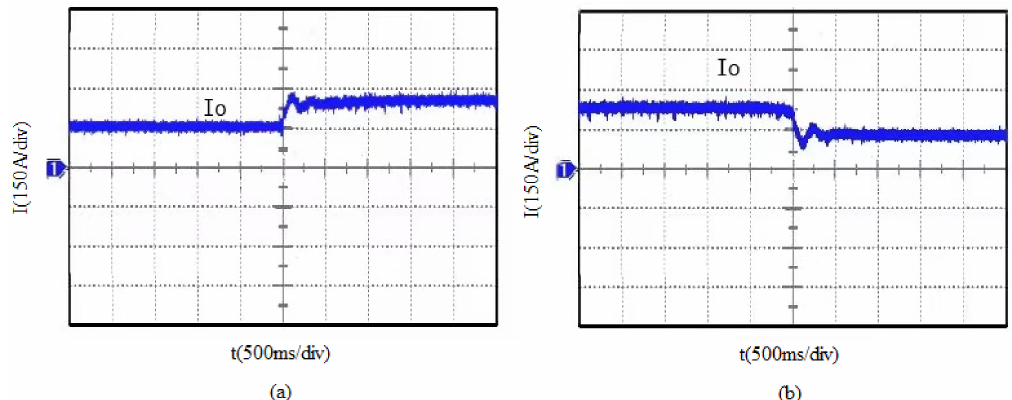
Figure 27. Output current waveforms of load mutation: ( a ) load increases; ( b ) load decreases.